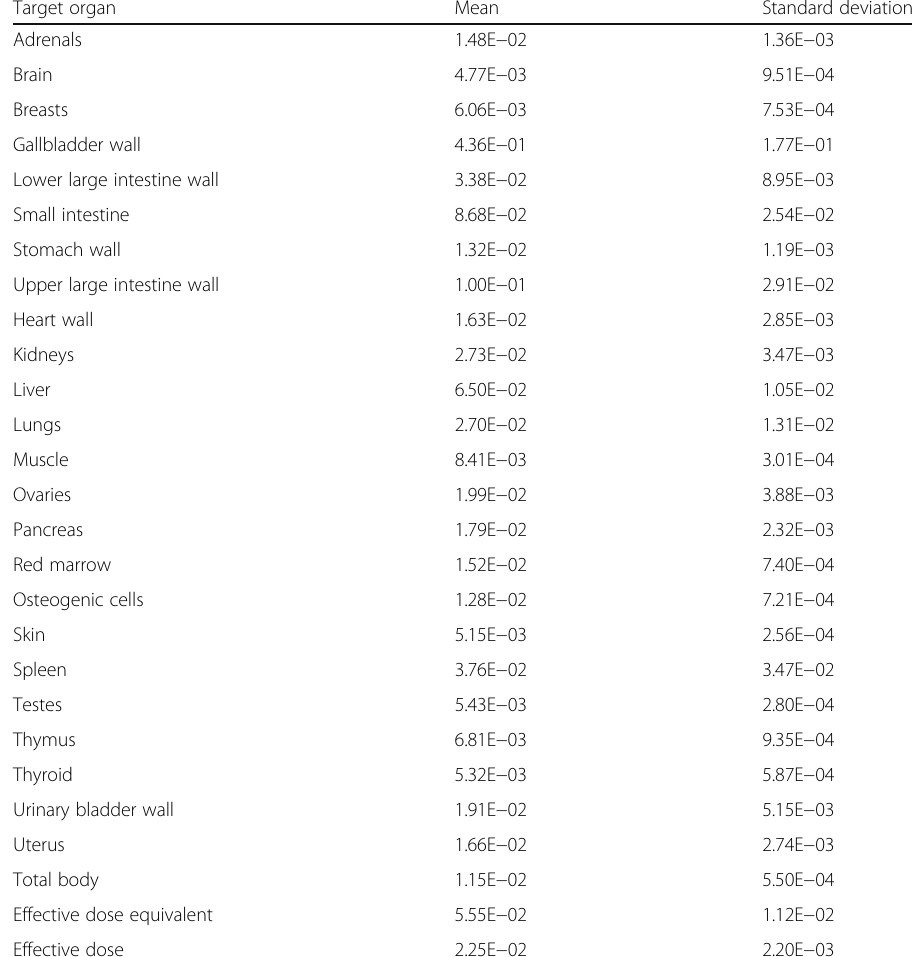
Table 1 Mean FTP radiation dose estimates for the control group (mSv/MBq, n = 10) Target organ Mean Standard deviation